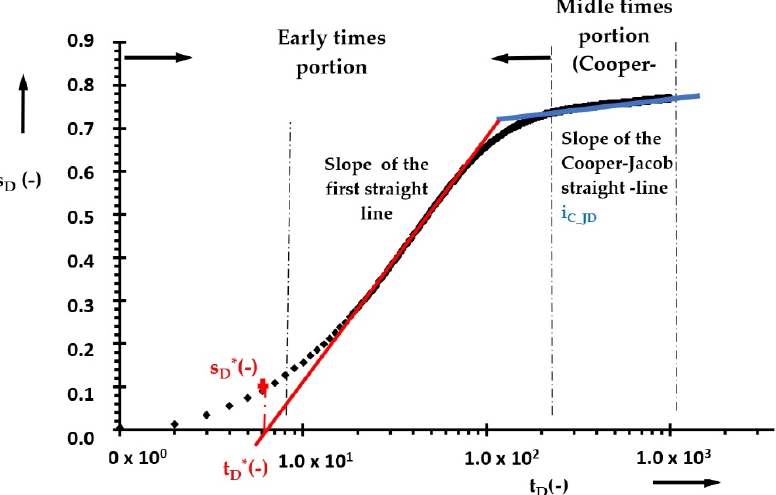
Figure 3. Graph showing wellbore storage and skin effects on pumping test ( s D -dimensionless drawdown, t D -dimensionless time).